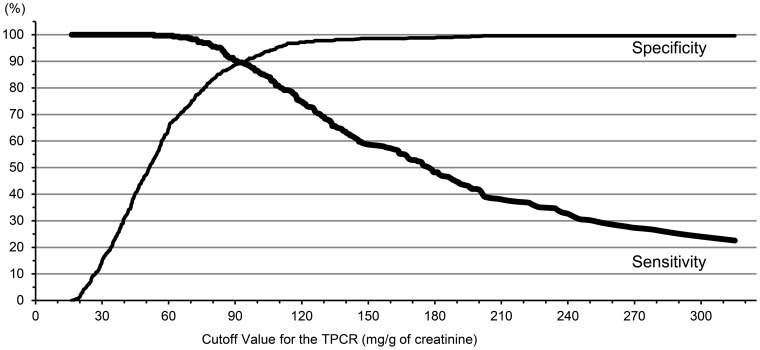
Relationship between the cut-off value and specificity/sensitivity.TPCR, total urine protein-to-creatinine ratio. Note that the higher cut-off value increased the specificity while decreasing the sensitivity.